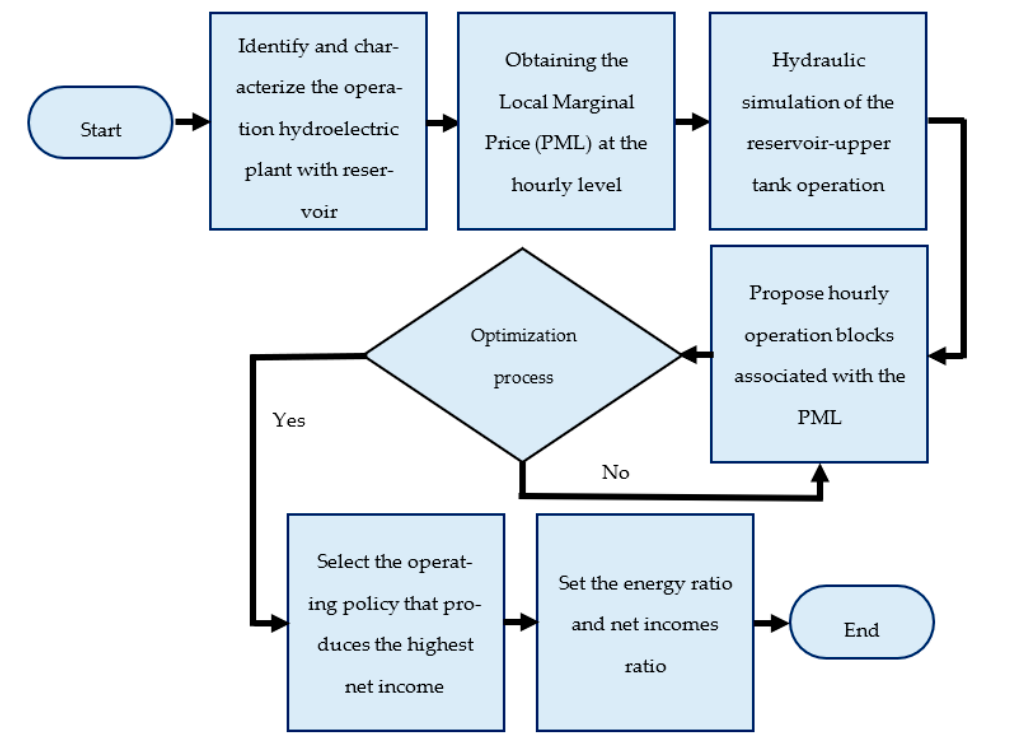
Figure 4. Conceptual diagram to establish an optimal operation policy for the PHES .